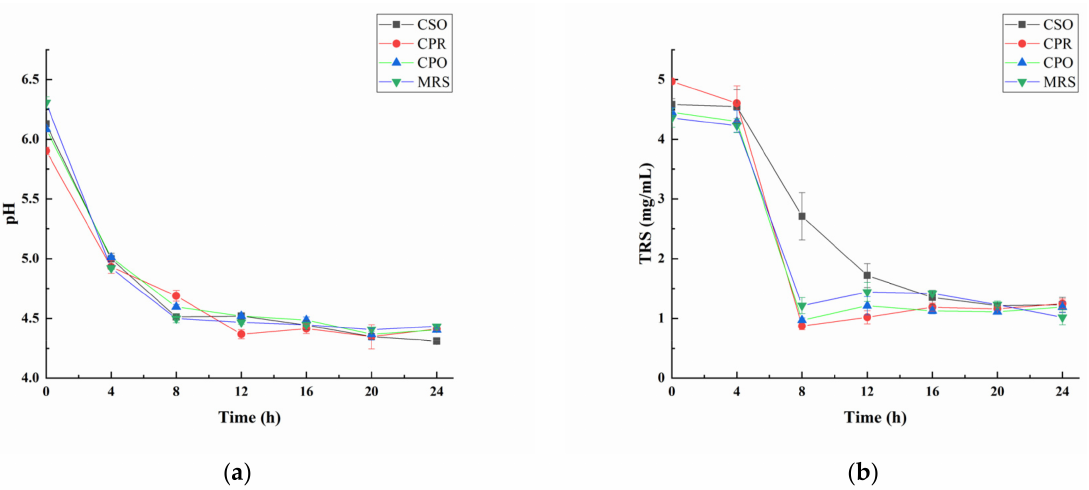
Figure 1. Changes of pH ( a ) and total reducing sugar (TRS) ( b ) during the growth of L. reuteri . Values are presented as mean ± standard deviation ( n =